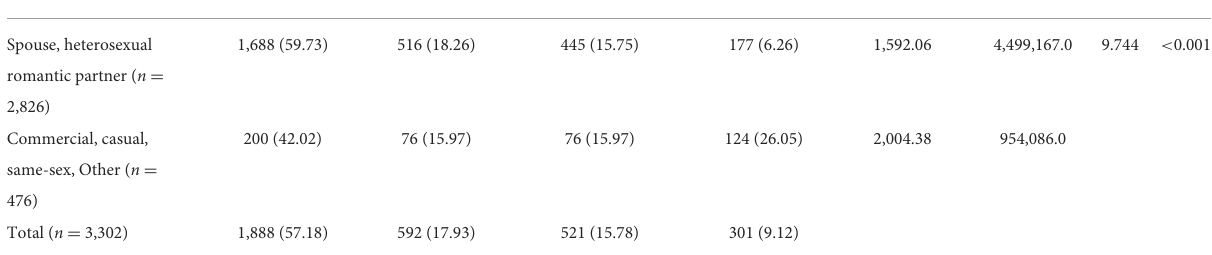
TABLE 8 Frequency of condom use during